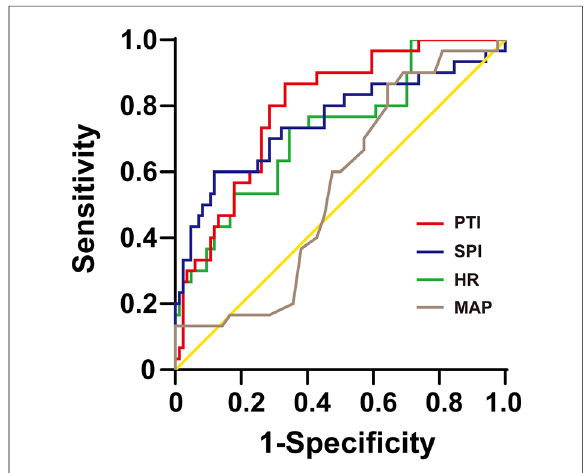
FIGURE 2 The ROC curves of PTI, SPI, HR, and MAP to distinguish between mild (0 – 3) and moderate-to-severe (4 – 10) postoperative pain (FLACC, 0 – 10). ROC, receiver-operating characteristic; SPI, surgical pleth index; PTI, pain threshold index; HR, heart rate; MAP, mean arterial pressure.